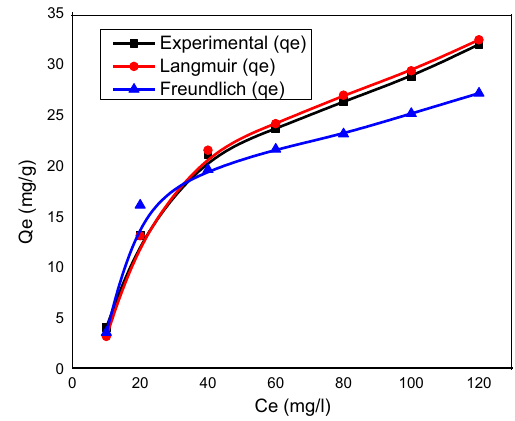
Fig. 9 Plot to show influence of coexisting anions Fig. 10